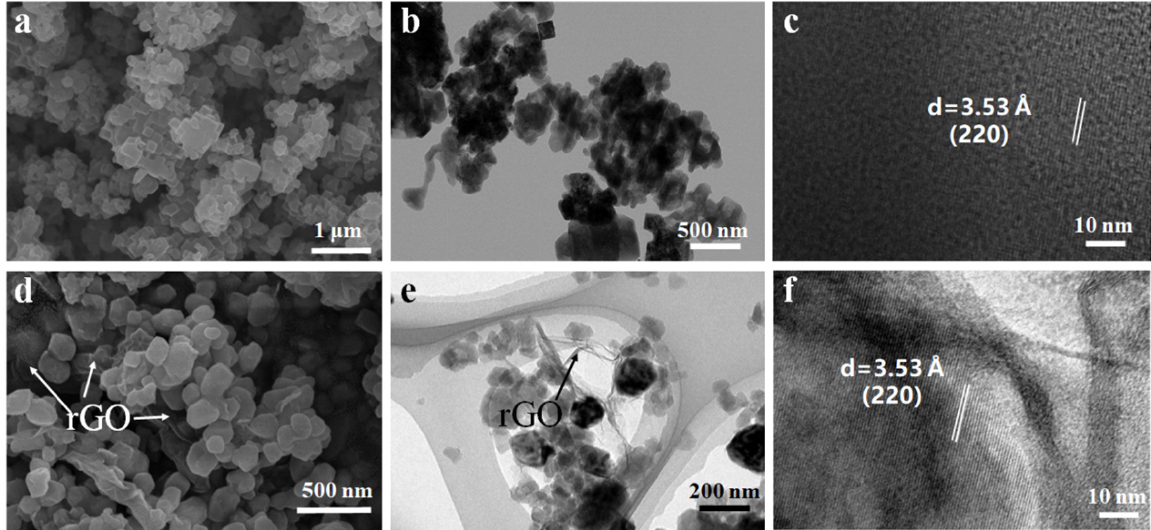
Figure 1. Microstructure of KCoHCP − H2 − EK and KCoHCP − H2 − EK/rGO: ( a – c ) SEM, TEM, HRTEM images of KCoHCP − H2 − EK respectively; ( d – f ) SEM, TEM, HRTEM images of KCoHCP − H2 − EK/rGO, respectively.